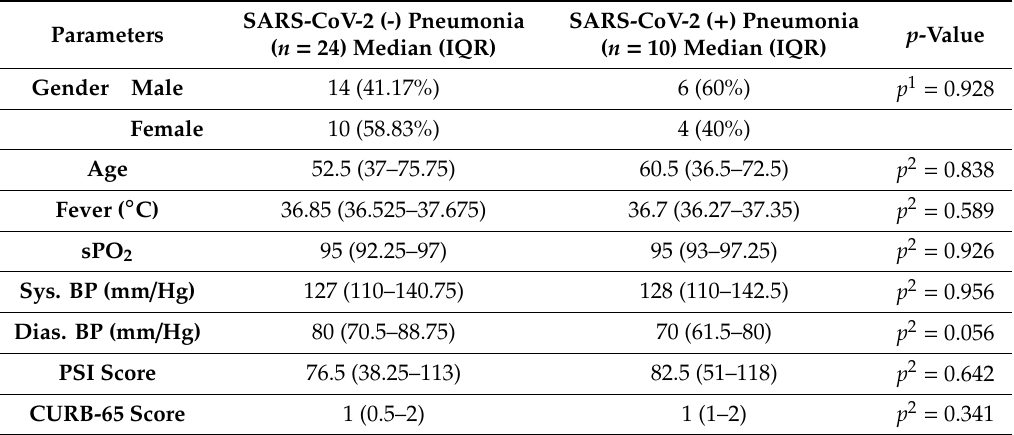
Table 1. Vital and clinical parameters of the groups.